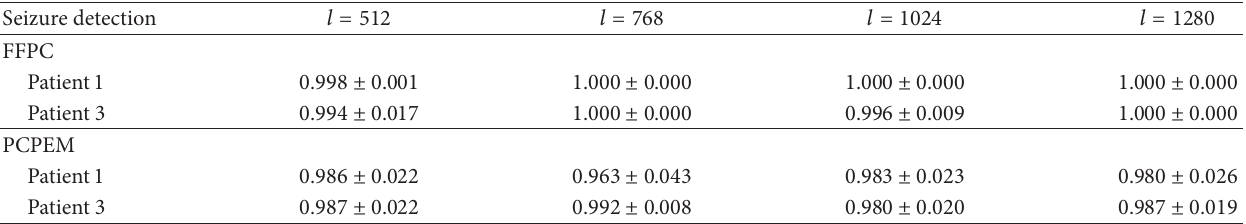
Table 2: The classification accuracy (i.e., the proportion of all signal types correctly detected) using methods of FFPC and PCPEM with different values of 𝑙 for the epileptic seizure detection problem using one hour long EEGs from Freiburg